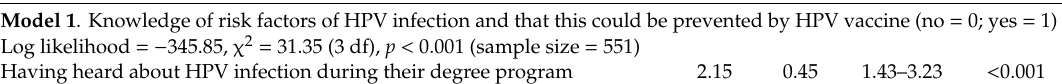
Table 3. Multivariate logistic analysis to characterize factors associated with di ff erent outcomes of interest. Variable OR